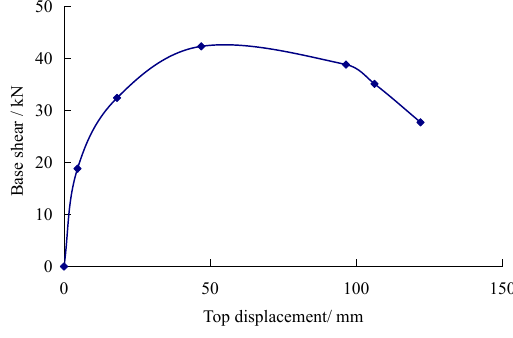
Figure 11. Capacity spectrum of the test model.